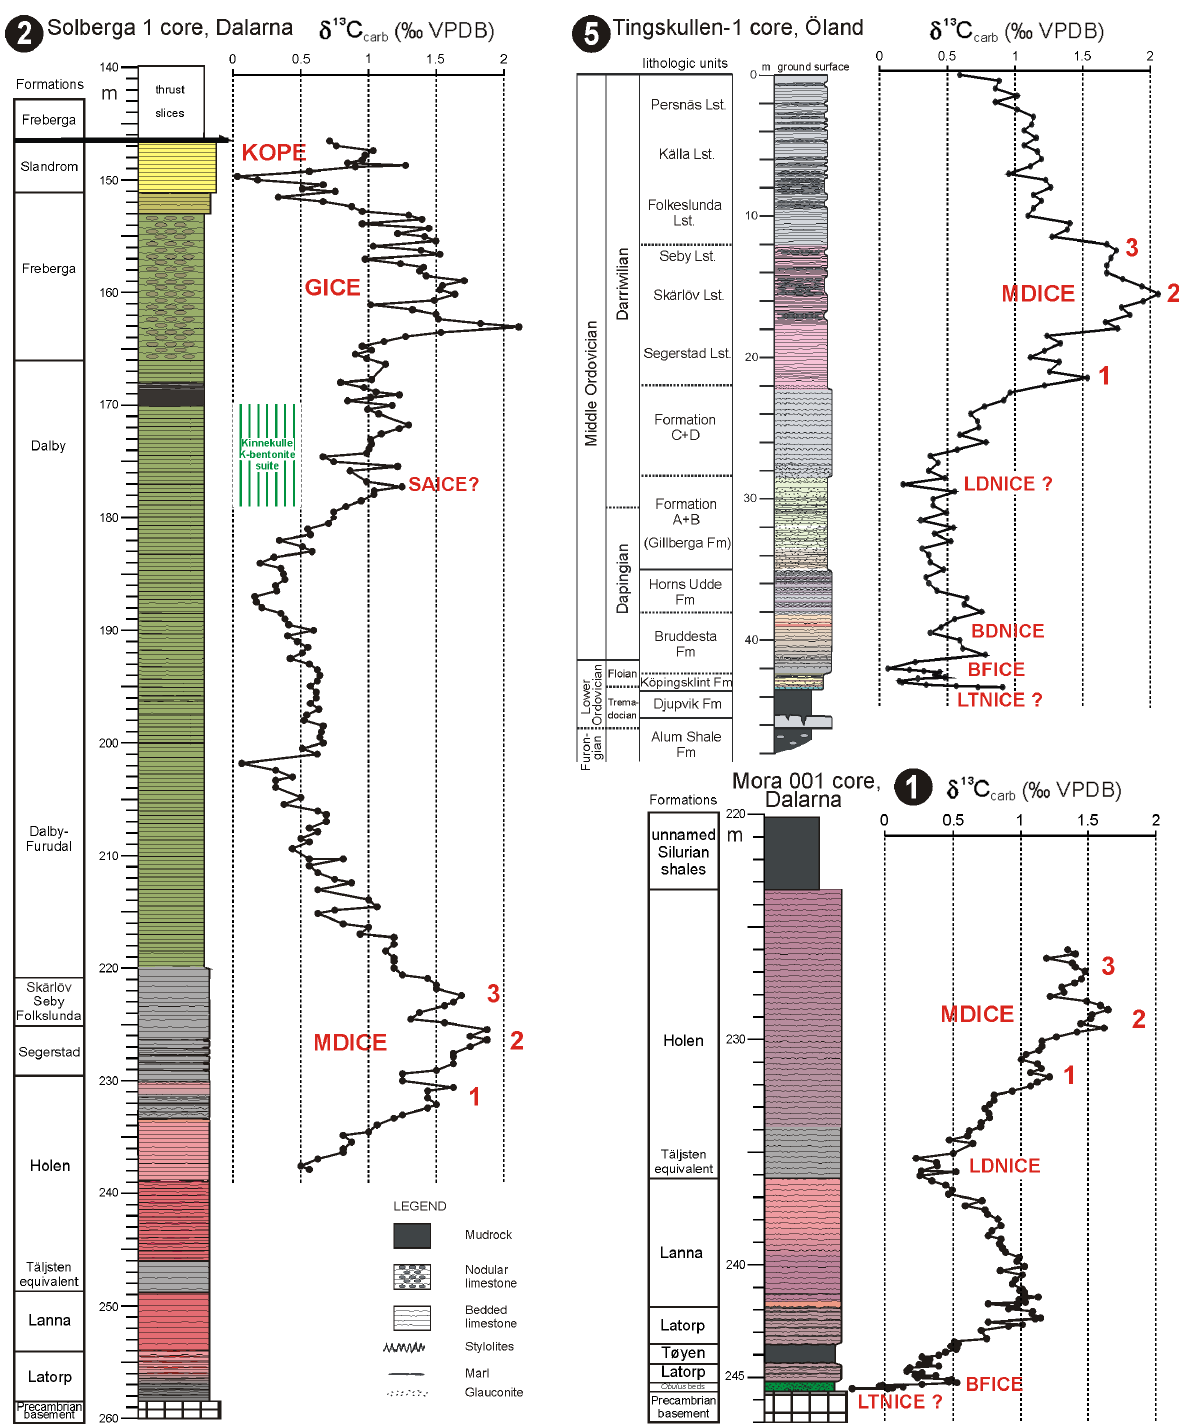
Fig. 4. Stratigraphy, δ 13 C chemostratigraphy and sedimentary profiles of the upper Tremadocian through lower Katian succession in the Siljan core sections (Mora 001 and Solberga 1) and of the upper Tremadocian through Darriwilian strata in the Tingskullen-1 core from northeastern (cid:214)land (Calner et al. 2014). The encircled numbers beside the names of the cores refer to the corresponding location numbers shown in Fig.